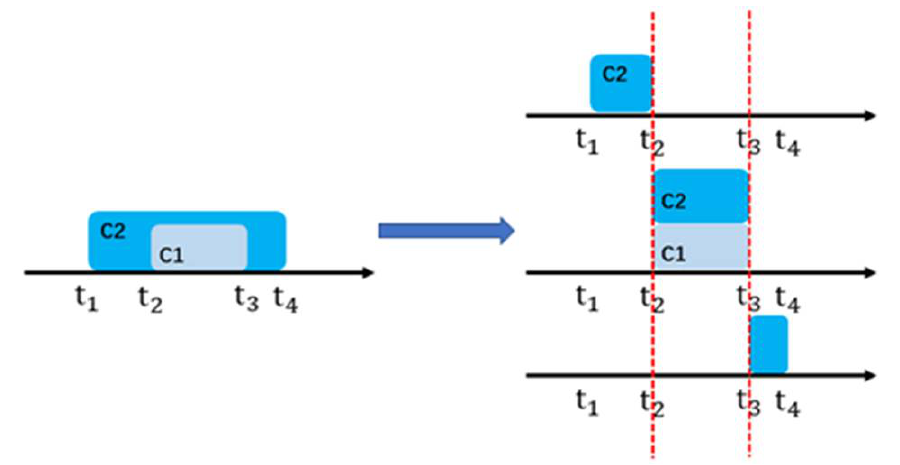
Figure 1. Event time series cutting diagram.